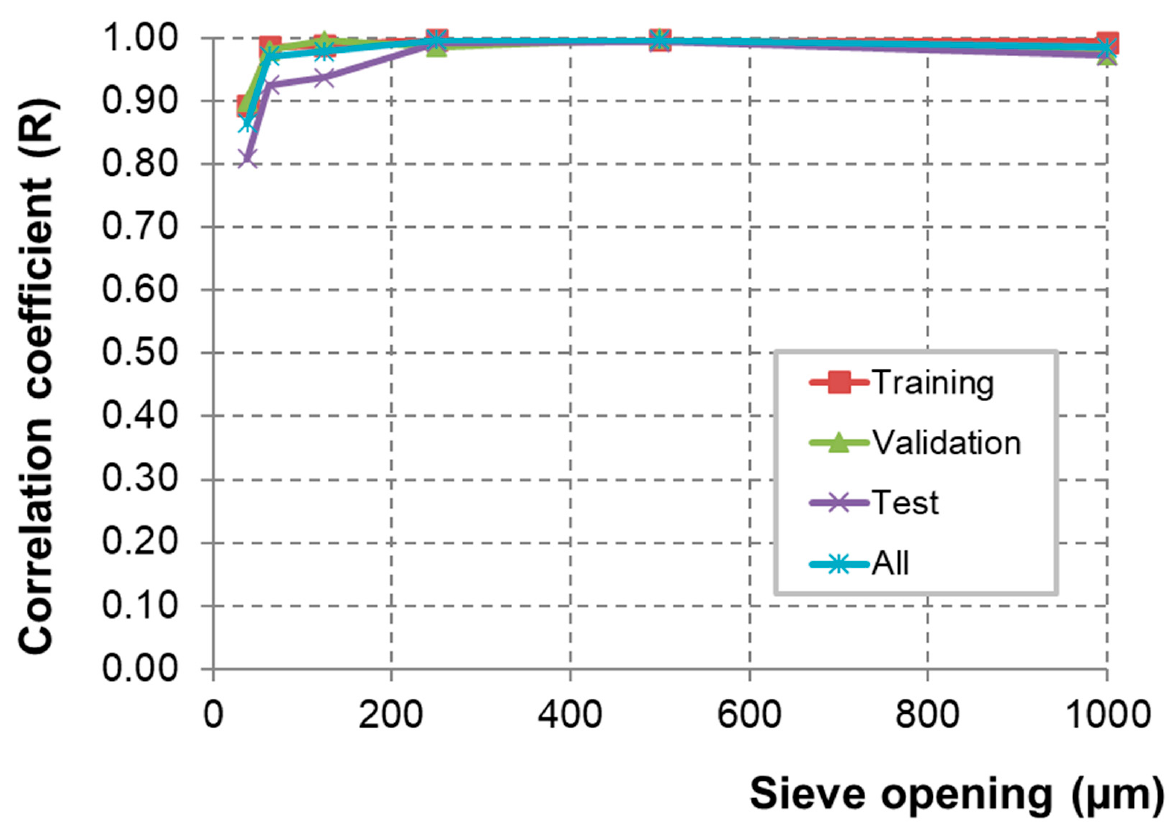
Figure 5. Correlation coefficient (R) of the training, validation, and test datasets in the ANN models for six SO levels. Table 1. Training results of six PPC prediction ANN models.